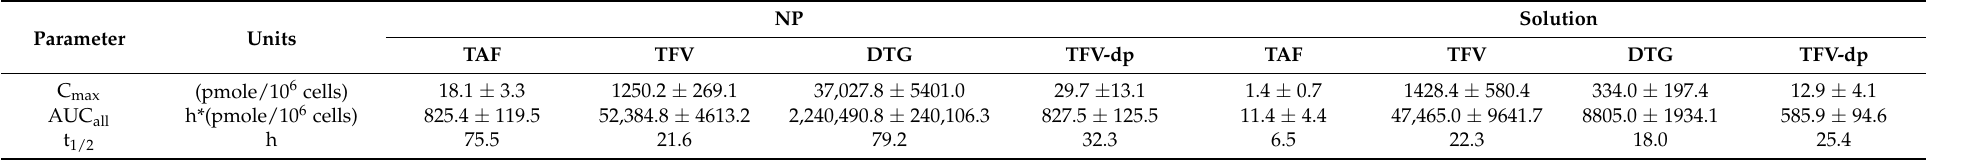
Table 4. Comparative intracellular kinetics study of DTG, TAF, active drug (TFV), and its metabolite (TFV-dp) upon xfR5-D+T NPs or D+T solution